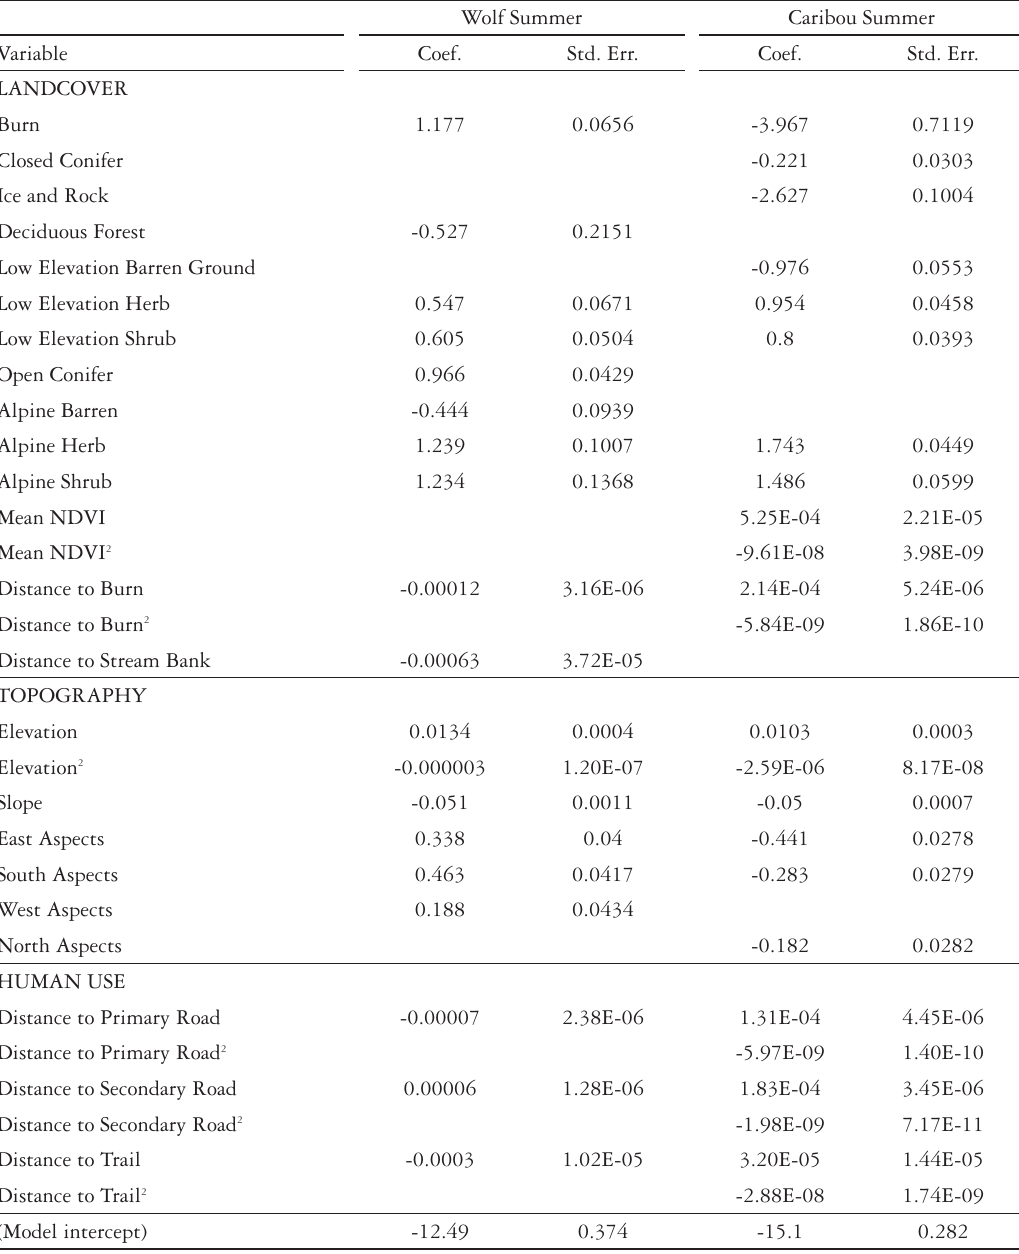
S-table 5. Wolf and Caribou summer resource selection function (RSF) model for Banff and Jasper National Parks. Covariates without coefficients were non-significant in our stepwise model selection process and thus cat- egorical variables (landcover type and aspect) without coefficients are included in the model intercept. For distance variables a positive coefficient shows avoidance (i.e., use increases with distance) while negative coef- ficients show selection (i.e., use decreases with distance). Squared variables are quadratic terms. All variables included in the models were significant at a level ≤